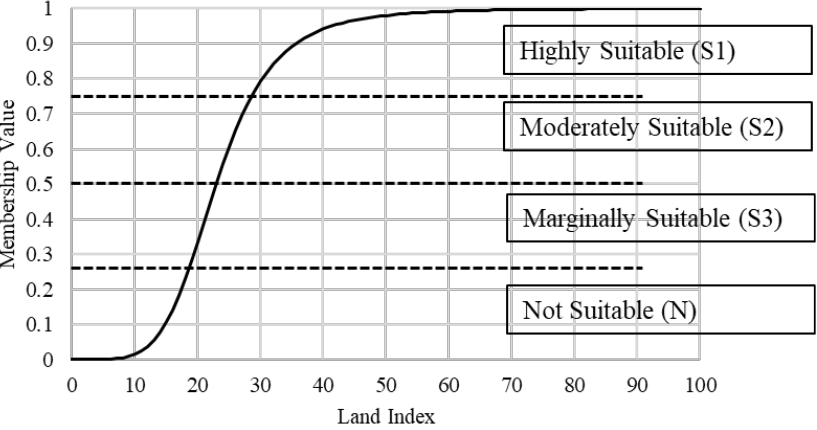
Figure 7. Land suitability class selection for jute and sugarcane cultivation using fuzzy membership function and land index.